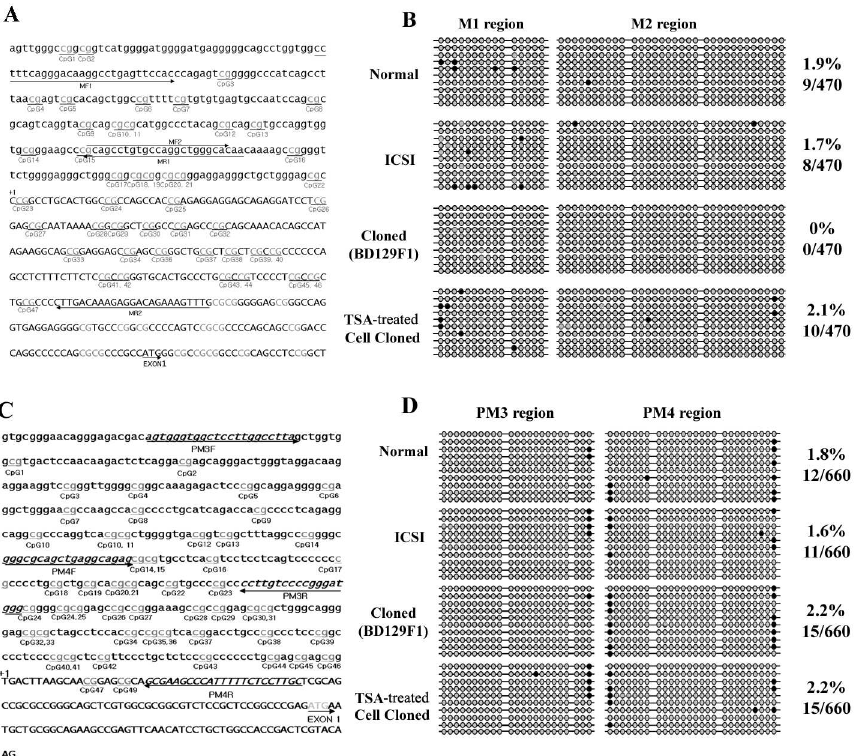
Fig 4. Methylation patterns at the promoter regions of TIMP-2 and PBEF . (A) Positions of the 47 CpG dinucleotides within the 641-bpregionupstream of the TIMP-2 transcription initiationstart site. (B) The methylationstatus of these CpG sites in NM control, ICSI-derived, cloned,and TSA-treated cloned placentae, as determinedby bisulfite sequencing of at least 20 independentPCR clones. (C) The 49 CpG dinucleotides within the 652-bpregionupstream of PBEF . (D) The methylationstatus of the CpG sites shown in (C). Gray circle, unmethylated; black circle, methylated. Percentages indicate the proportions of total available CpG sites that are